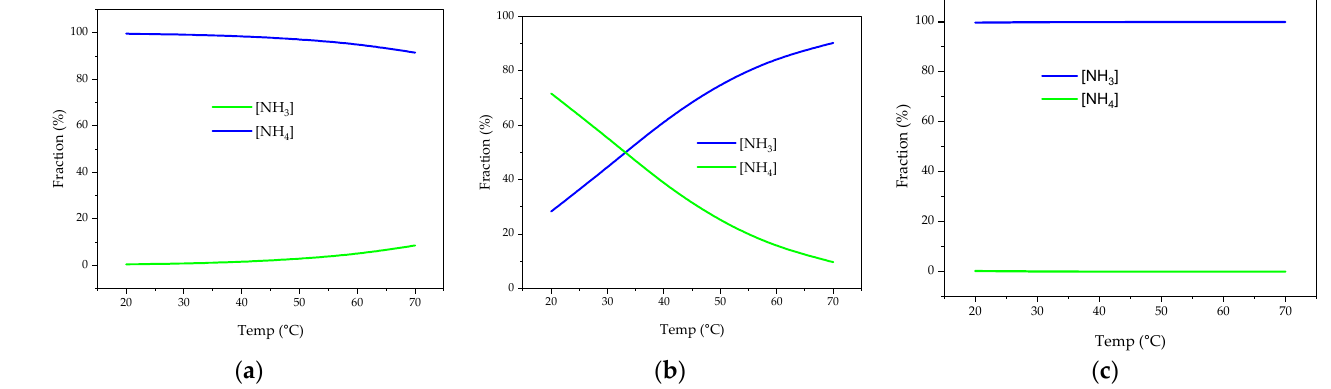
Figure 9. Effect of temperature on NH 3 /NH 4+ speciation at ( a ) pH =7, ( b ) pH =9 and ( c ) pH = 12. Polymeric or ceramic membranes can be used for nitrogen recovery. Ceramic membranes have attractive traits when considering nitrogen recoveries, such as ease of cleaning, narrow pore size distribution, wide pH range, and long operating life [127]. However, their high cost gives polymeric membranes a competitive edge over them. Given the low quality of wastew- ater, frequent cleaning and replacement may be required for maintaining stable